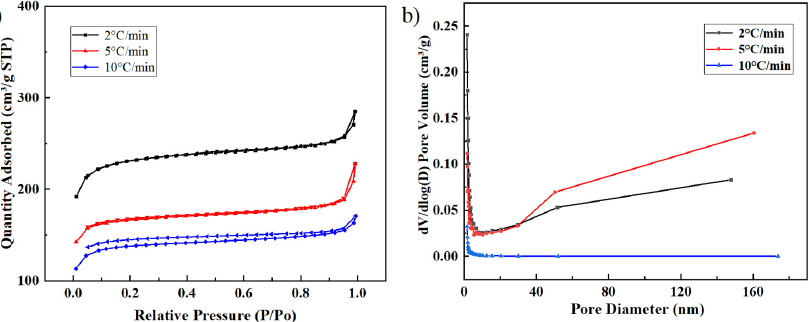
Figure 5. ( a ) N 2 adsorption and desorption isotherms of Co–ZIF–8, ( b ) pore–size distributions of Co–ZIF–8.